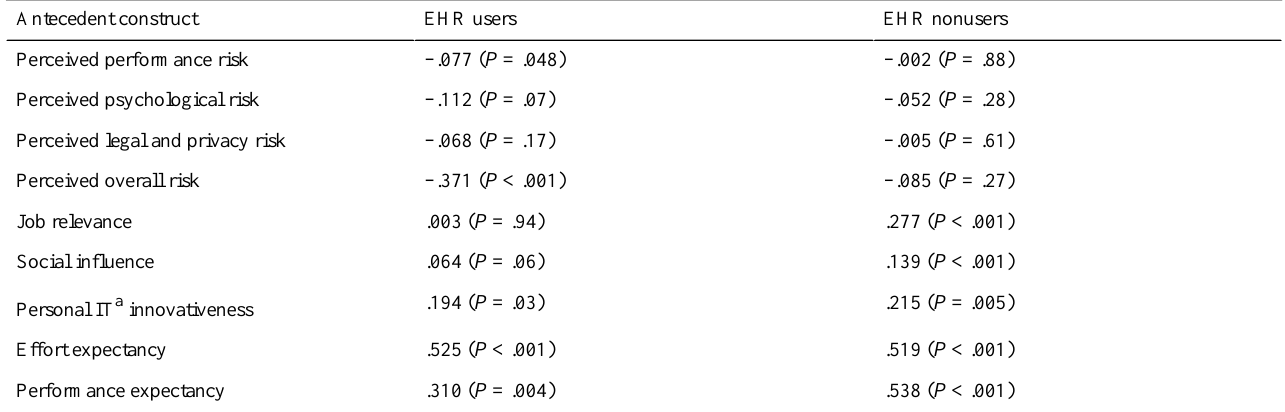
Table 4. Total effects and their significance levels on behavioral intention